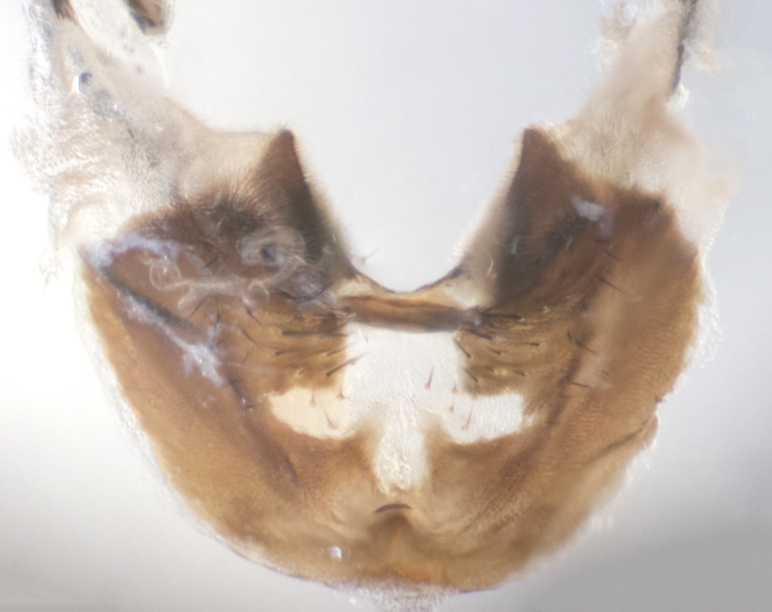
sternite 5, ventral view